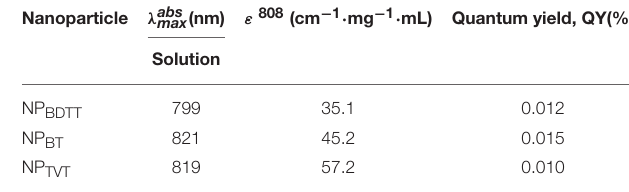
TABLE 2 | Optical and fluorescence quantum yield of NPs.